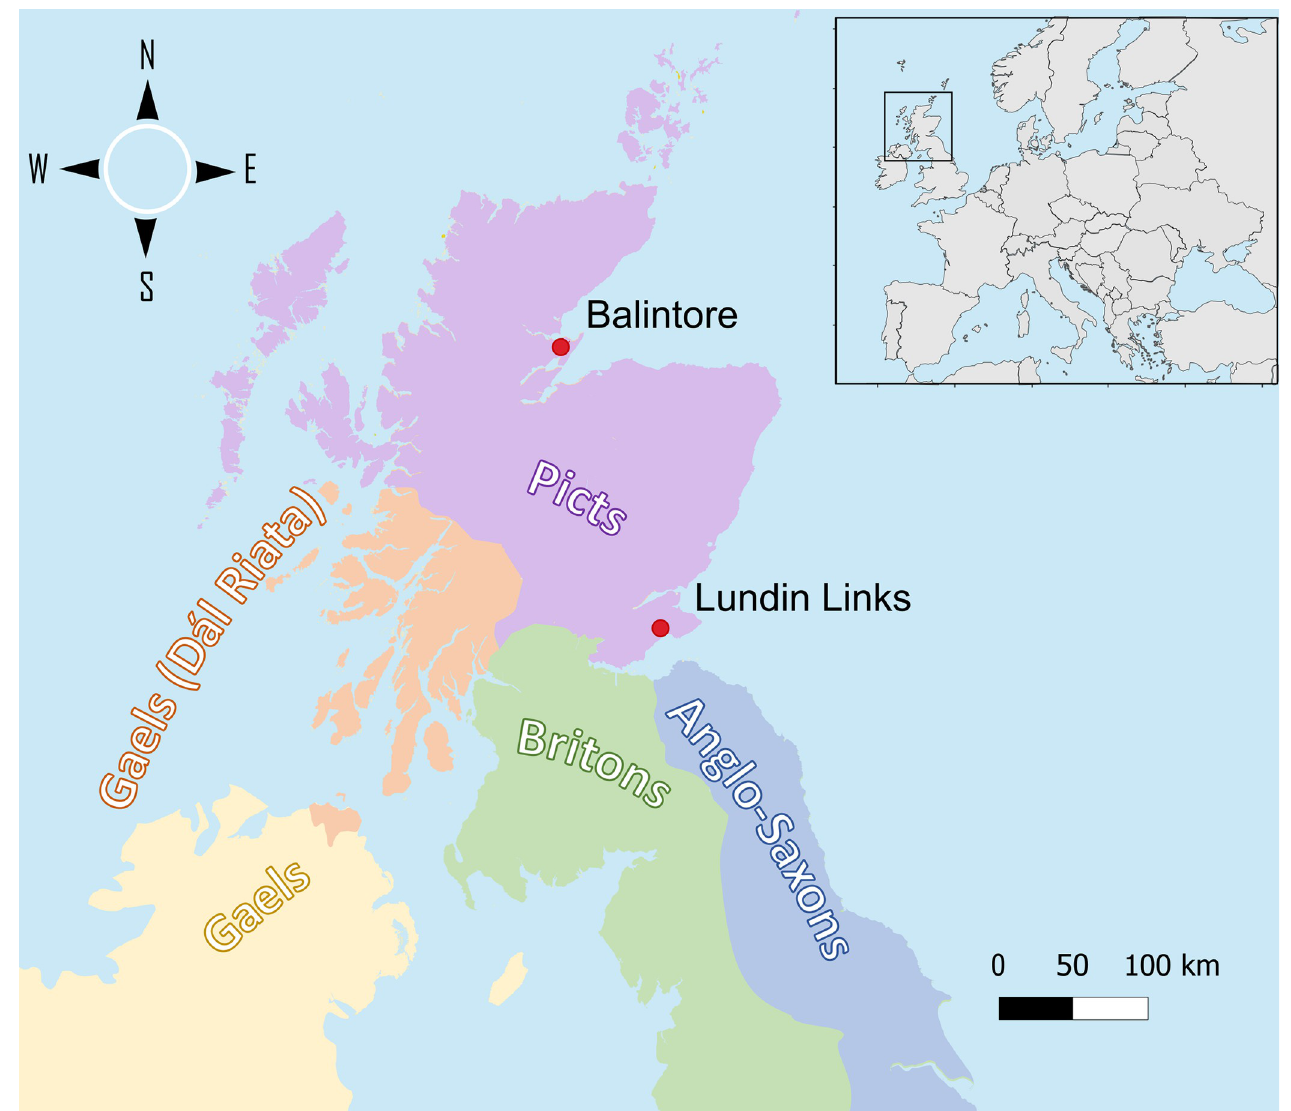
Fig 1. Sampling location and the regions under ancient Brittonic, Irish and Anglo-Saxon control around the 7 th century